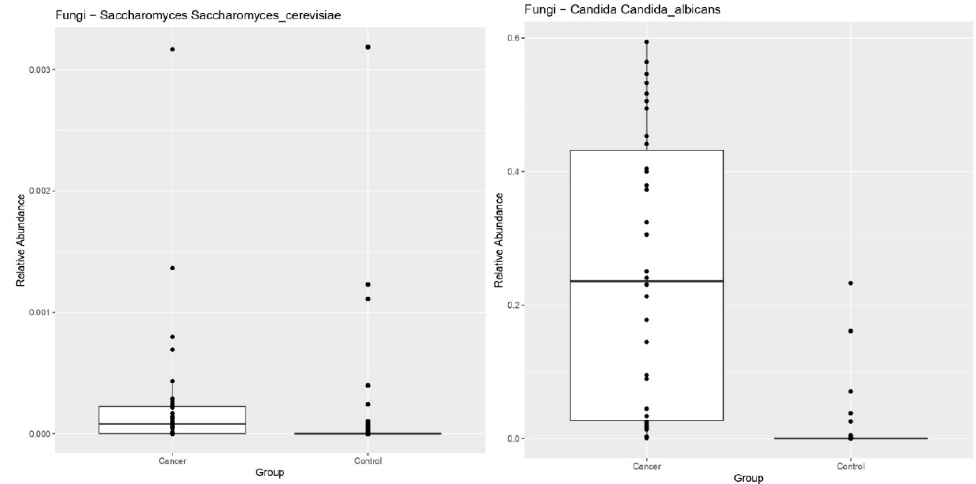
Figure 1. Patients with GEP-NENs had significantly decreased relative abundance of bacterial species and an increase in the relative abundance of fungi ( Candida species, Ascomycota, and species belonging to saccharomycetes) compared to controls ( p = 0.0013).